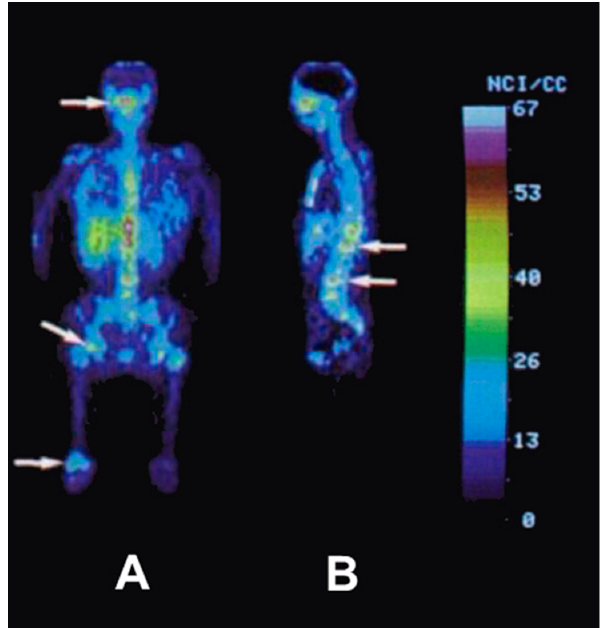
Figure 10. Whole-body images of a female patient with a history of breast cancer 4 h after injection of 86 Y-citrate. ( A ) Anterior view with coronal slices summed up. ( B ) Eight centimeter-thick sagittal section in the median plane of the patient. The arrows indicate different metastases.